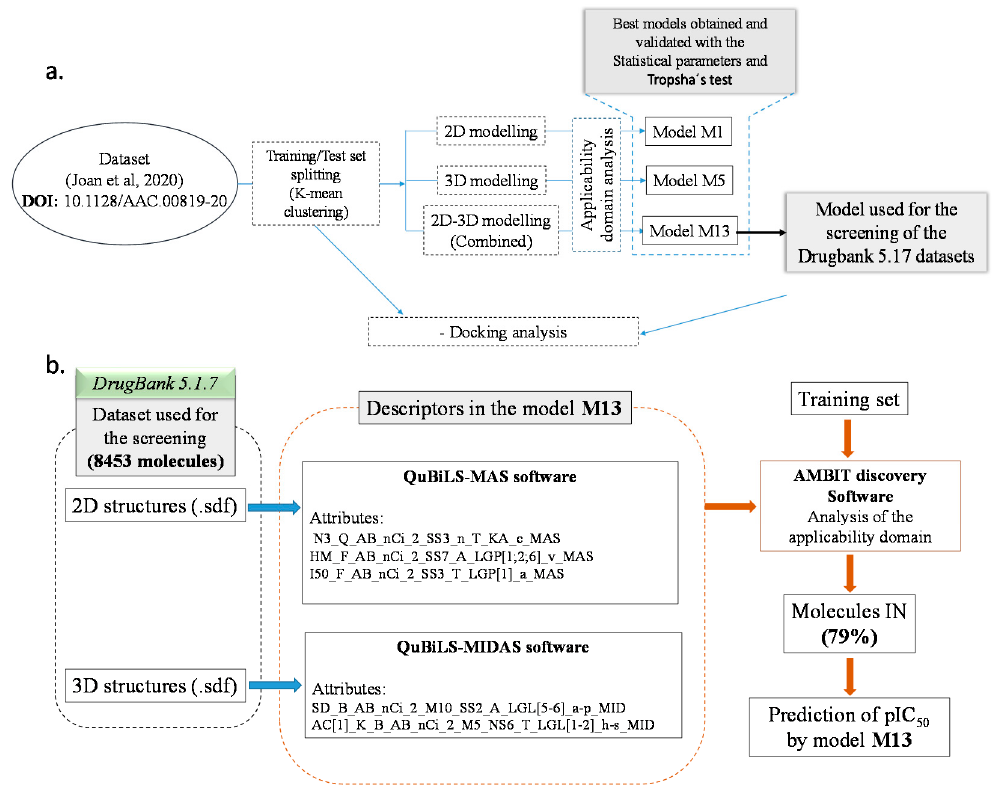
Figure 2. ( a ) Quantitative Structure-Activity Relationships (QSAR) and molecular docking simulation approach to finding possible drugs against SARS-CoV-2. ( b ) DrugBank screening and pIC 50 prediction procedure.